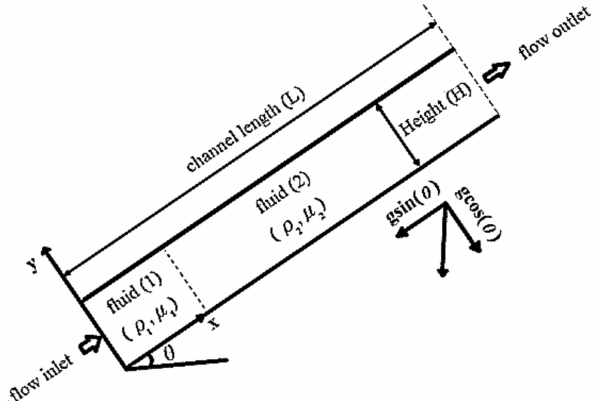
Figure 1. A schematic illustration of the geometrical configuration (not to scale) and initial flow